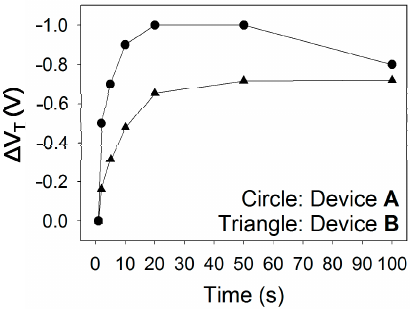
Figure 6. Variations in the threshold voltages of the flexible TIPS-pentacene TFTs with the c-PVP/Y 2 O 3 composite and c-PVP gate insulators, during a prolonged bias stress test.